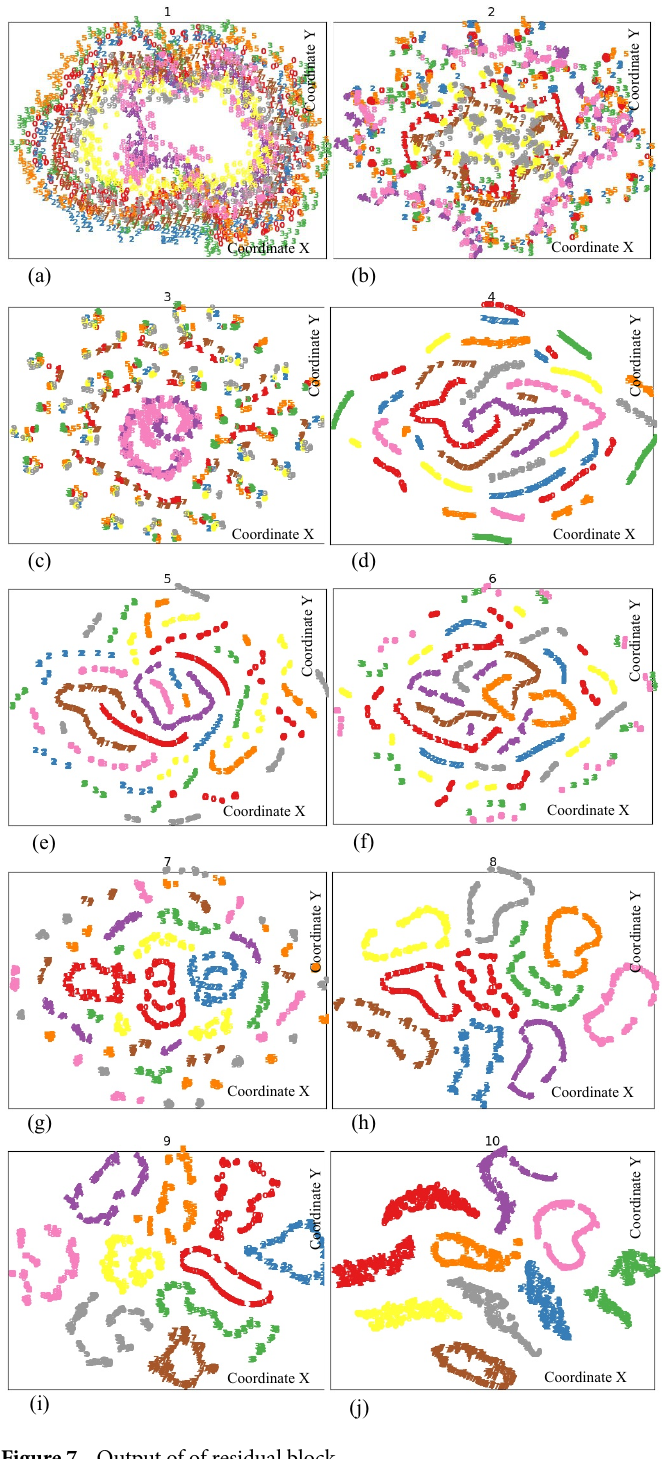
Figure 7. Output of of residual